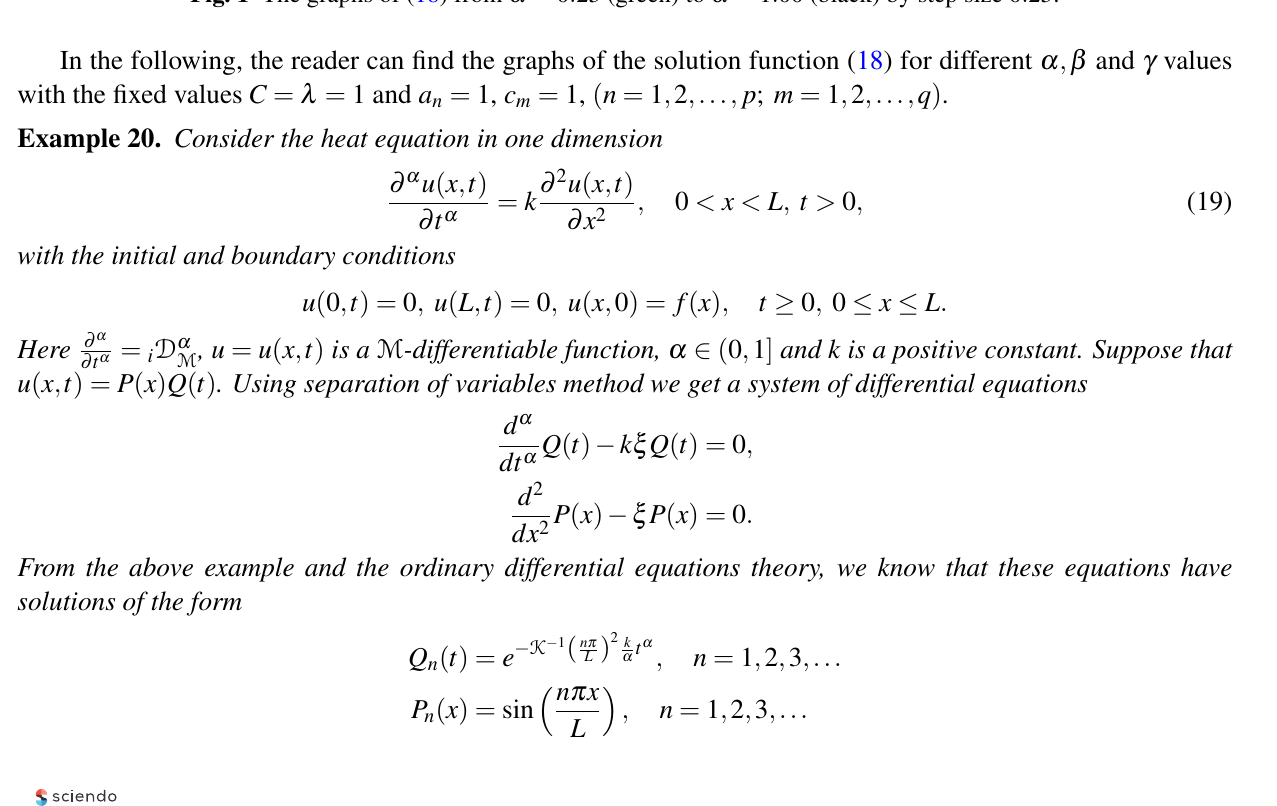
Fig. 1 The graphs of (18) from α = 0 . 25 (green) to α = 1 . 00 (black) by step size 0 .